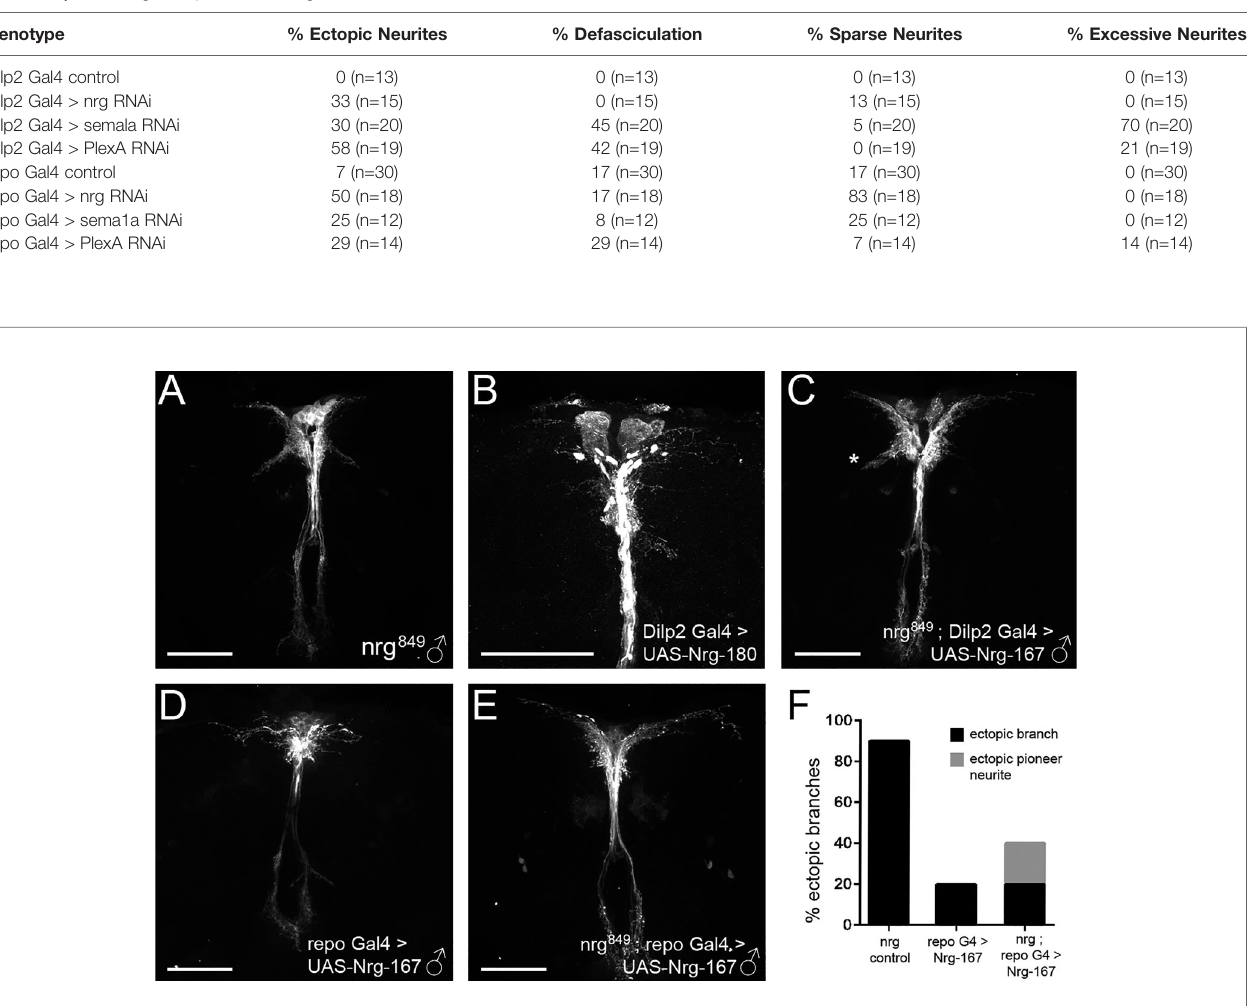
FIGURE 6 | Glial-speci fi c expression of Nrg rescues the ectopic branching phenotype of nrg 849 mutants. Attempts to rescue the (A) ectopic branch phenotype of nrg 849 hemizygous males with (C) IPC-speci fi c expression of Nrg failed to rescue the ectopic branching (marked by asterisk). However, (E, F) restoration of Nrg-167 expression in glia was suf fi cient to rescue the ectopic branching phenotype in nrg 849 hemizygous males. Overexpression of Nrg in (B) IPC neurons or (D) glia results in decreases in lateral neurite complexity as well as a redistribution of DenMark. Scale bars = 50 m m.